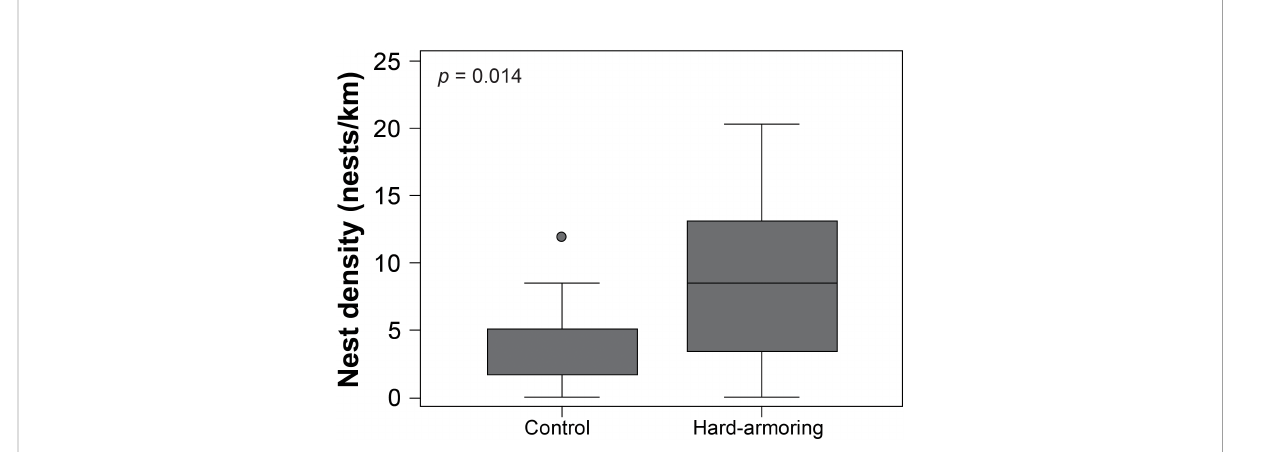
FIGURE 3 Nest density was signi fi cantly higher at the hard-armoring structures in comparison to the control site for nesting leatherback sea turtles ( Dermochelys coriacea ) on Tequesta and Jupiter Inlet Colony Beaches, Florida, USA. The middle line represents the median, the boxes represent the fi rst and third quartiles, while the whiskers represent the range. The circle is an "outside value" that is greater than 1.5, but less than 3 times the upper